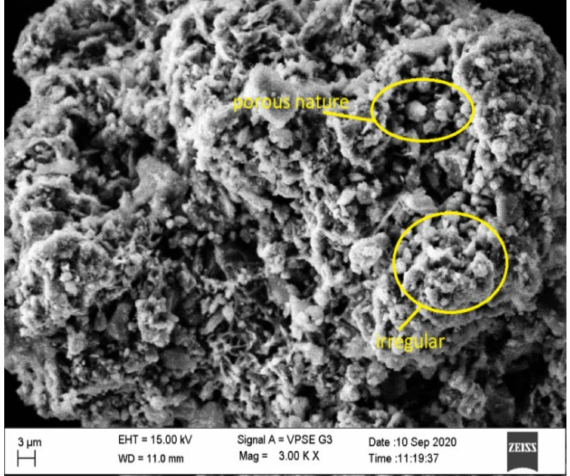
Figure 11. SEM image of steel slag.